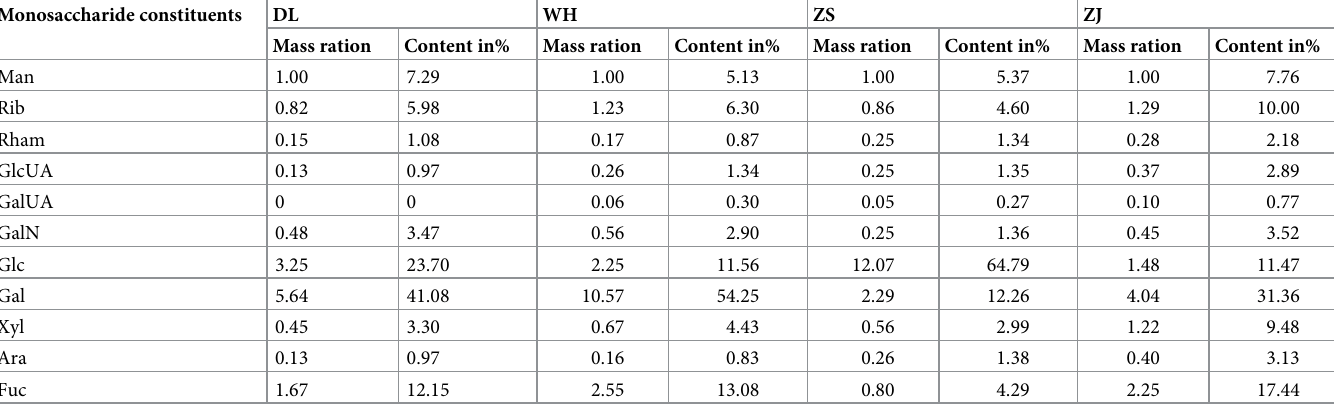
Table 1. Monosaccharide constitutions of RPM crude polysaccharides from four Chinese coastal locations. DL, WH, ZJ and ZS represent for crude polysaccharides from the Dalian, Weihai, Zhanjiang and Zhoushan RPMs respectively. Monosaccharide constituents